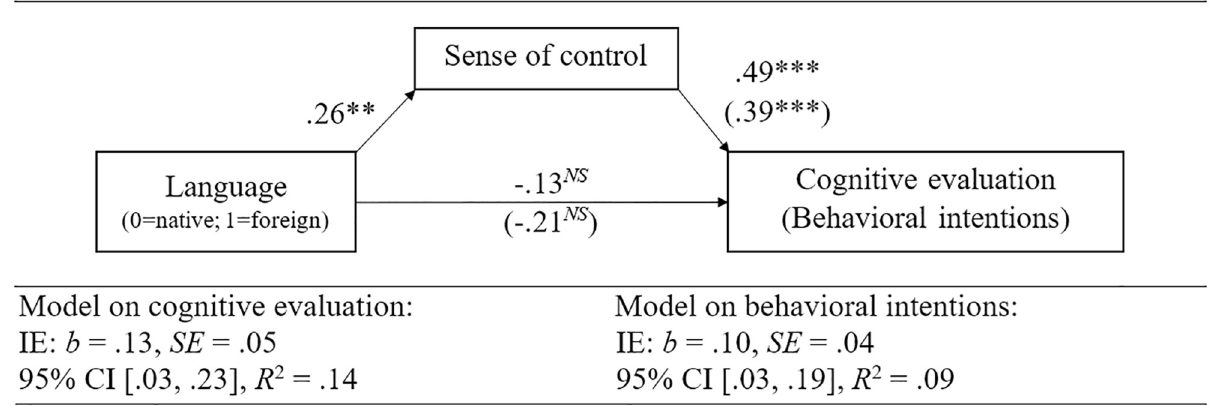
Fig 2. Mediating effects of sense of control on the cognitive evaluation of the pandemic mitigation measures and behavioral intentions (all instructions). Notes: IE = indirect effect, b = unstandardized regression coefficient. Results without brackets = model on cognitive evaluation, results in brackets = model on behavioral intentions. �� p = .007, ��� p < .001. N = 605. Model 4, 5,000 samples, 95% CI, [44].